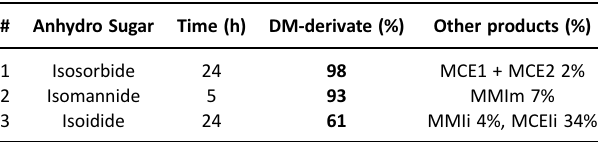
Table 4. Methylation of isosorbide and its epimers at relux tem- perature in the presence of NaOMe.